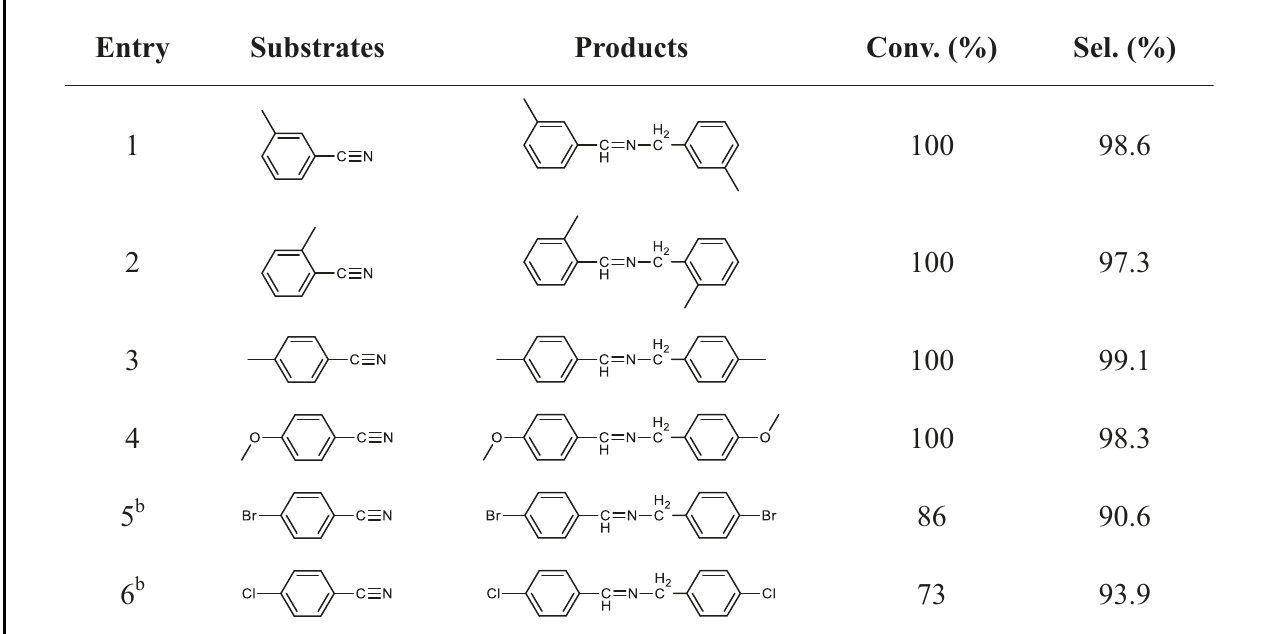
Table 2 Hydrogenation of various substituted nitriles a